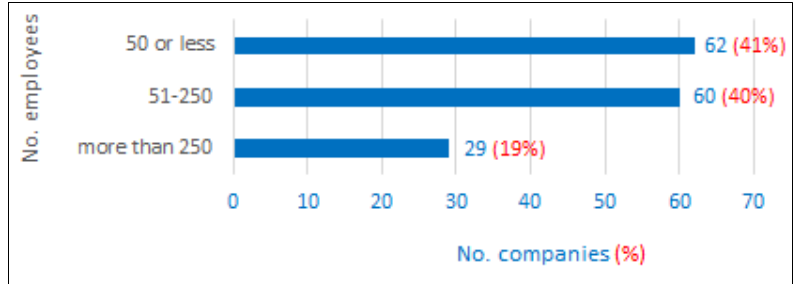
Figure 2. Number of employees (B2, n=151)